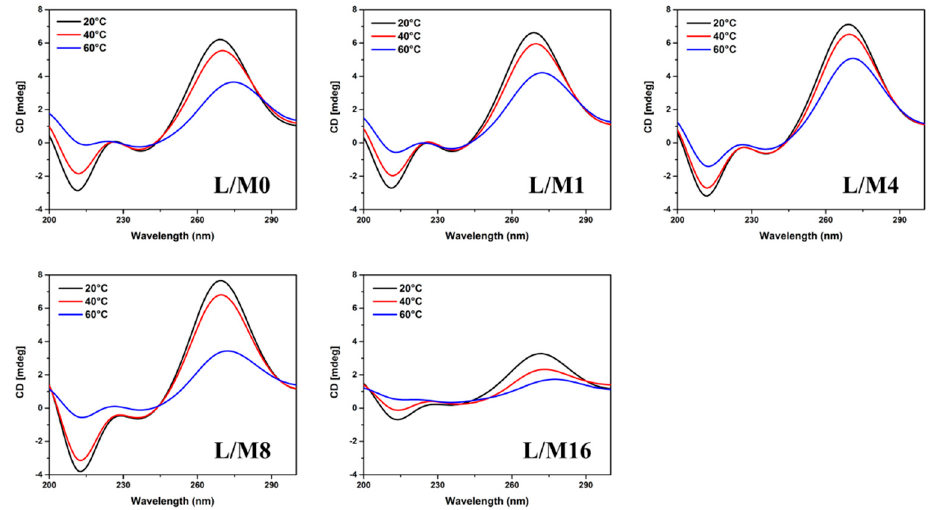
Figure 8. CD spectra of temperature effect on sisomicin binding towards annealed RNA repeats with different L/M. Annealed FM1 r(CUG) 10 RNA sample at 5 µM with a volume size of 200 µL; sisomicin to RNA molar ratios of 0, 1, 4, 8, and 16; FM1 r(CUG) 10 RNA–sisomicin CD spectra from 300–200 nm at 20–60 °C. Table 2. Change in ellipticity ∆ e at 270 nm (between 20 and 60 ◦ C) for annealed FM1 CUG × 10. L/M